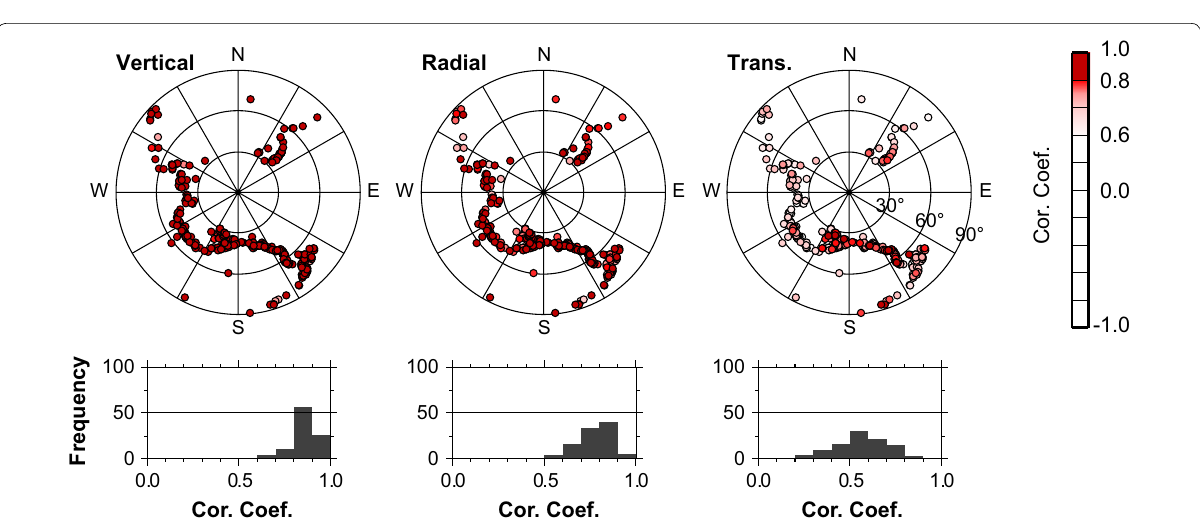
Fig. 4 Distributions of cross-correlation coefficients for short-wavelength teleseismic waveforms. Same as Fig. 4, but a low-pass filter of 1.5 Hz was